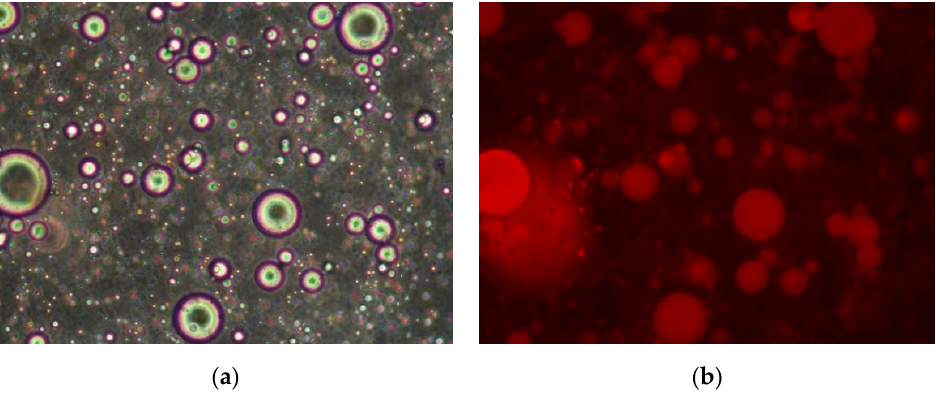
Figure 8. Fluorescent images of the dyed emulsions stabilized by RAOA at a final concentration of 5.0 mg/mL under ( a ) bright field and ( b ) dark field.